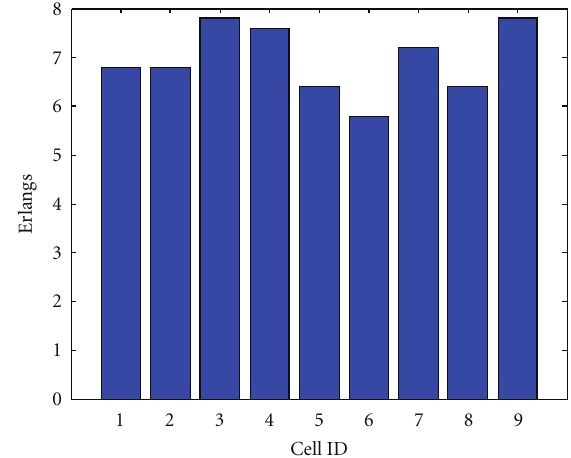
Figure 16: Load handled by the femtocells in optimized power (no. of FBSs =